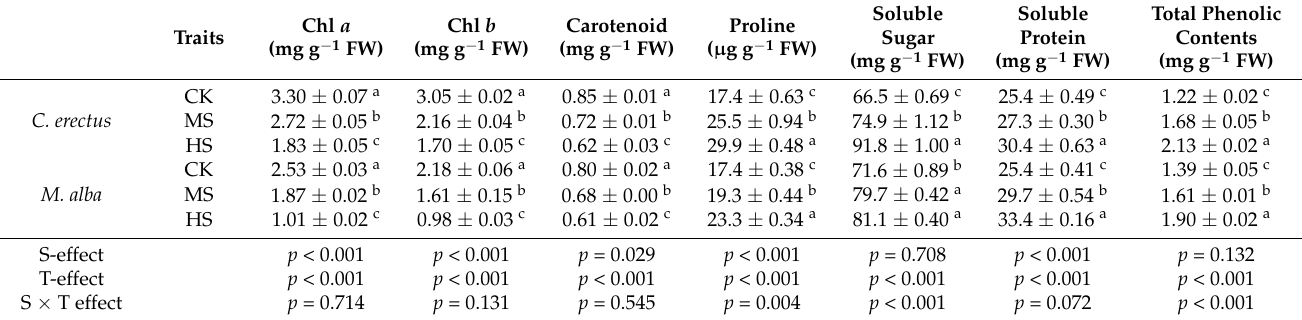
Table 2. Effect of water deficit on Chl a , b , carotenoid, proline, soluble sugar, soluble protein and total phenolic content under various water deficit treatments respectively in C. erectus and M. alba . All the traits were tested using a two-way ANOVA for species effect (S-effect), treatment (T-effect) and interaction (S × T) effects. All values represent the means ( ± SE) of species in various combinations. Small letters represent significant difference within each species tested using Dunnett’s test. All the tests were taken significant at p <